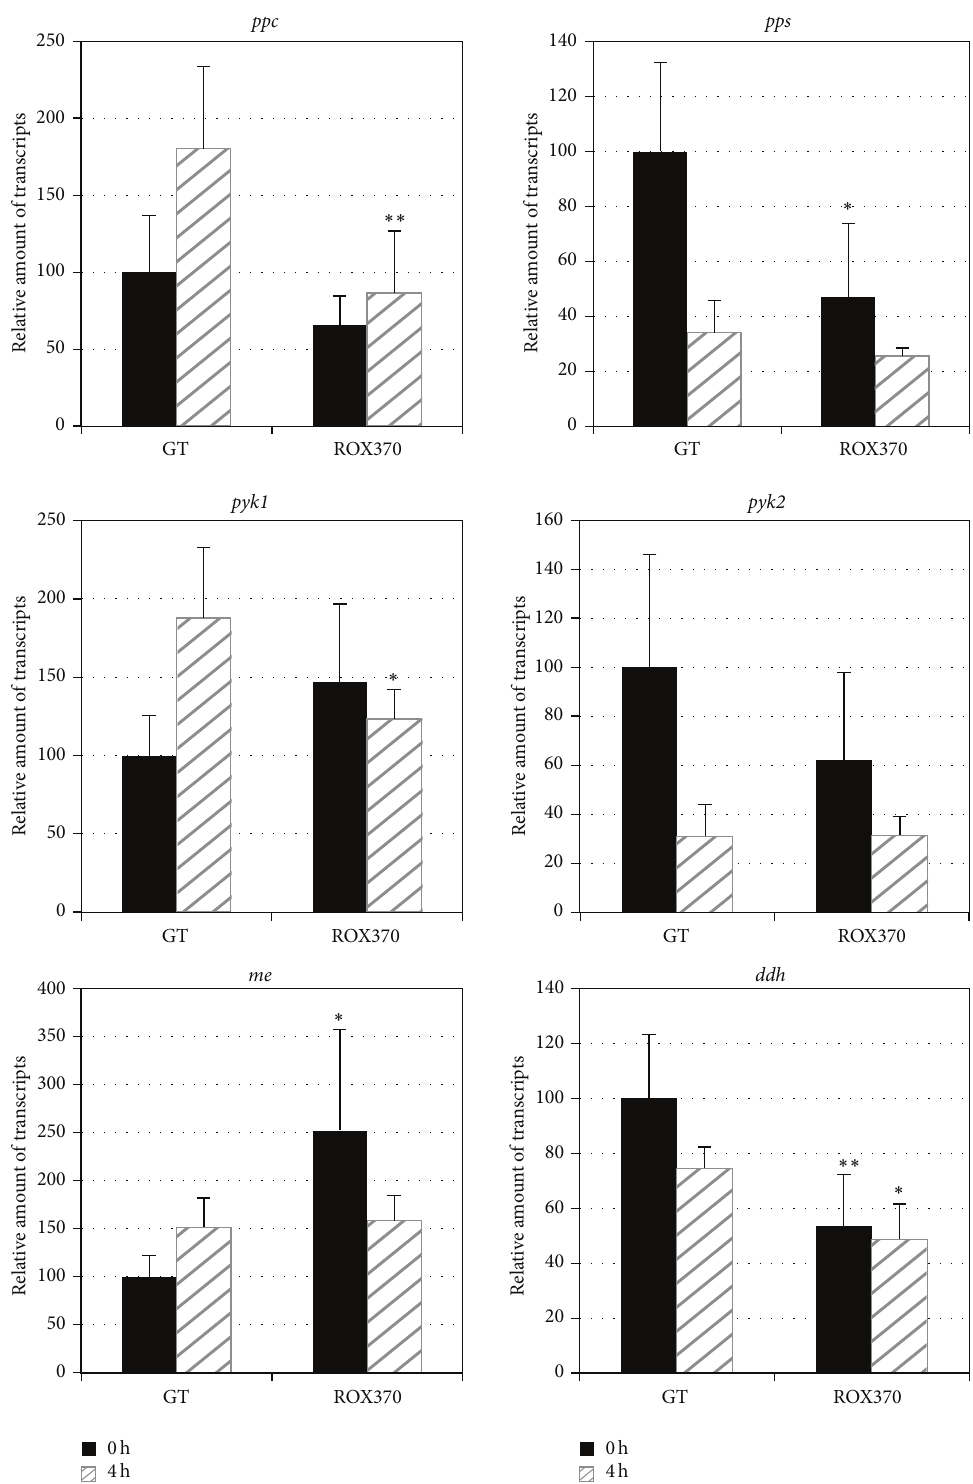
Figure 3: Quantitative real-time PCR analysis of transcription in GT and ROX370. Relative transcript levels of 6 genes involved in pyruvate metabolism( ppc , pps , pyk1 , pyk2 , me ,and ddh )areshown.Datarepresentthemean ± SDfromfourindependentexperiments.Transcriptlevels were calibrated relative to that of corresponding levels in GT under nitrogen-replete conditions (set at 100%). Asterisks indicate statistically significant differences between GT and ROX370 (Student’s 𝑡 -test; ∗ 𝑃 < 0.05 , ∗∗ 𝑃 < 0.005